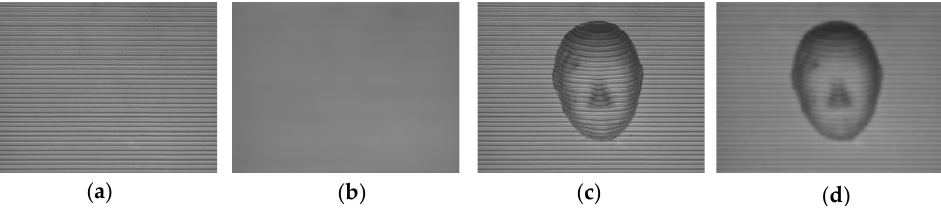
Figure 5. Gray imbalance correction: ( a ) reference plane background image before correction; ( b ) reference plane background image after correction ( c ) background image of the measured object before correction; and ( d ) background image of the measured object after correction.